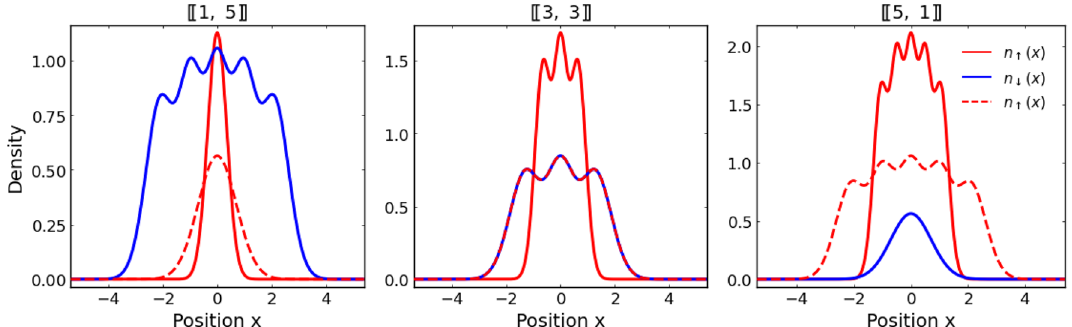
ini ini ( x ) � σ ( x ) � † of components for σ ˆ | � = � | ˆ 4 . For comparison, with the red dashed line, = 1 . Note, that increasing →